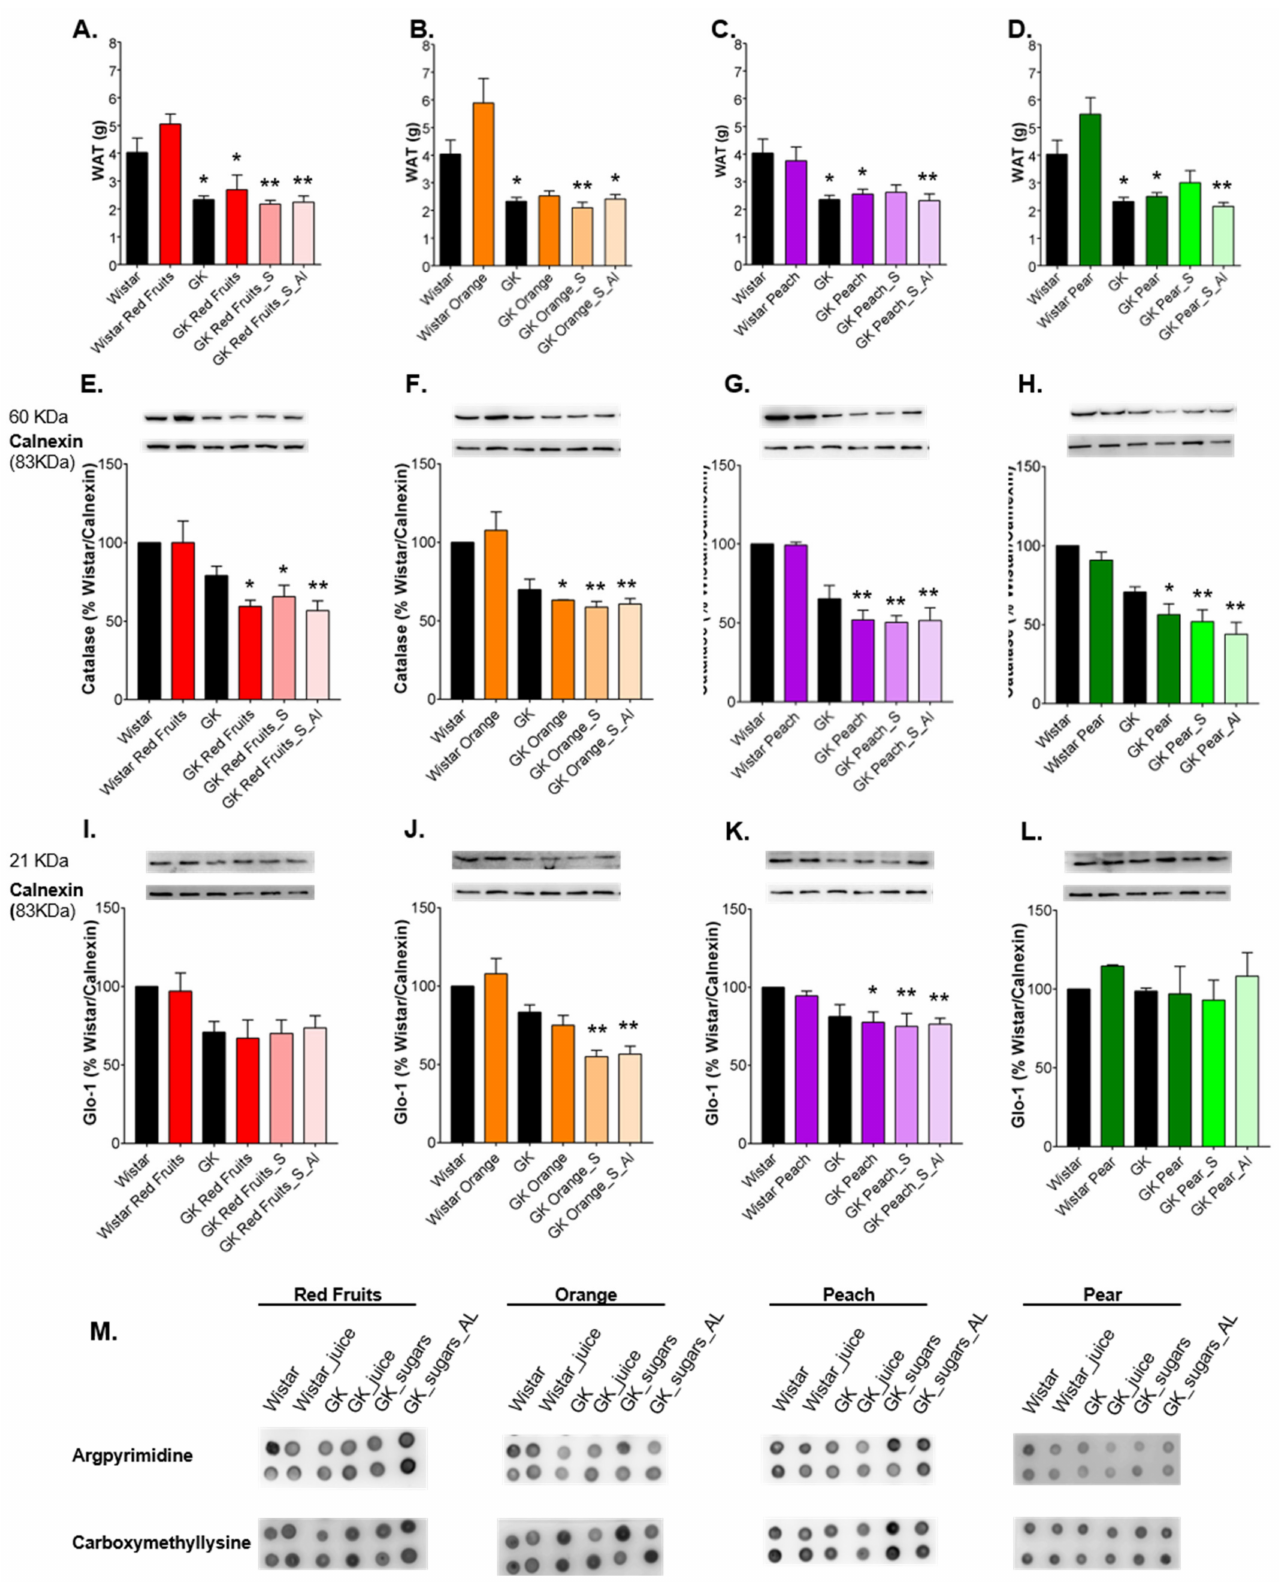
Figure 6. Epididymal adipose tissue weight was recorded ( A – D ) and the levels of catalase ( E – H ) and GLO-1 ( I – L ) in the tissue were determined by Western Blot. Representative dot blot membranes of CML and argpyrimidine in the adipose tissue are shown in ( M ). * different from Wistar. 1 symbol, p < 0.05; 2 symbols, p <